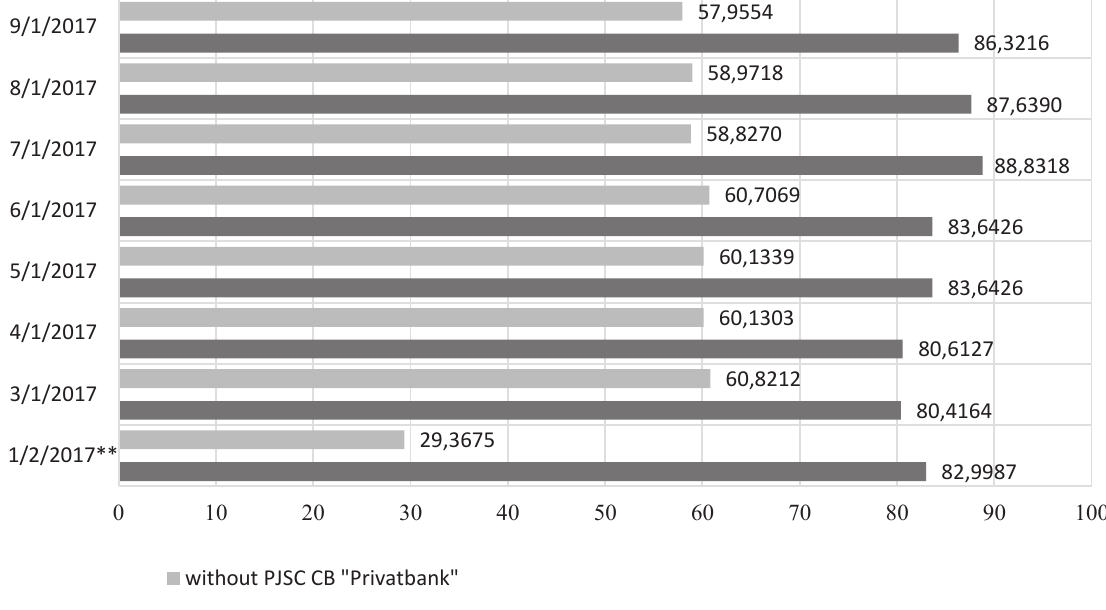
Figure 5. The share of non-working loans in PJSC CB “Privatbank” and without it in